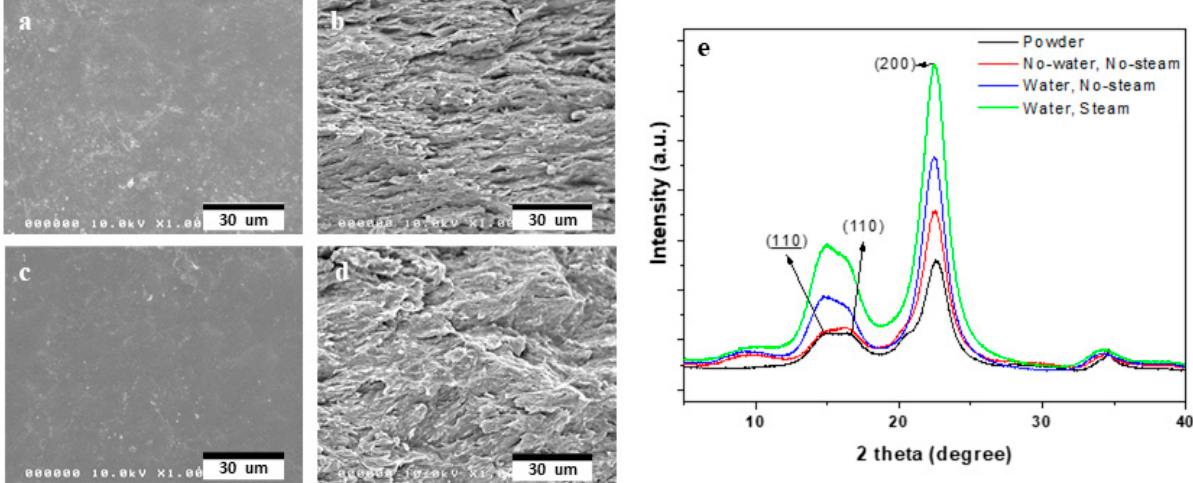
Figure 2. ( a ) Surface and ( b ) cross-section SEM images of non-steam processed bulk material, ( c ) surface and ( d ) cross-section SEM image of steam-processed bulk material, and ( e ) XRD results of the four cases: CNC powder (Powder), only CNC powder compaction (No-water, No-steam), non-steam-processed after mixing CNC powder and DI water (Water, No-steam) and steam-processed after mixing CNC powder and DI water (Water, Steam).